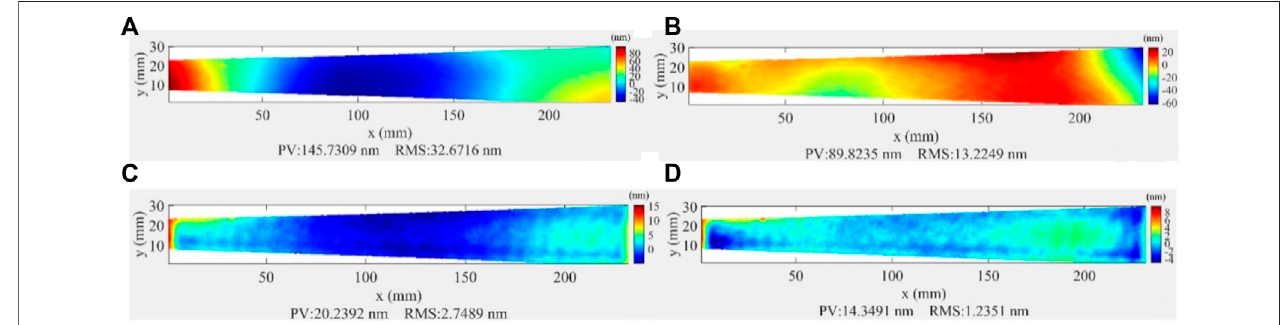
(PV) and from 33.9 to 2.2 nm (RMS). The height error after IBF with the best- fi t sphere subtracted is also shown in Figure 3B . The residual error is 4.8 nm (PV) and 0.88 nm (RMS) after subtracting the best- fi t sphere, while some small